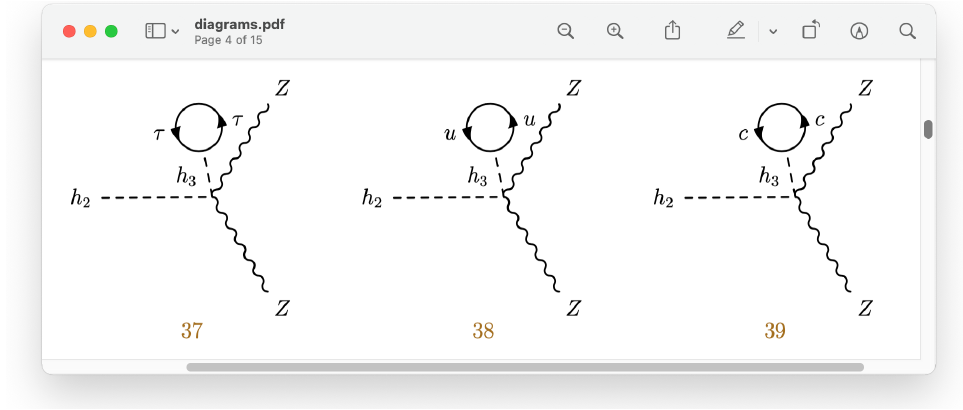
Figure 12 . Excerpt from diagrams.pdf for h 2 → ZZ at one-loop (in the